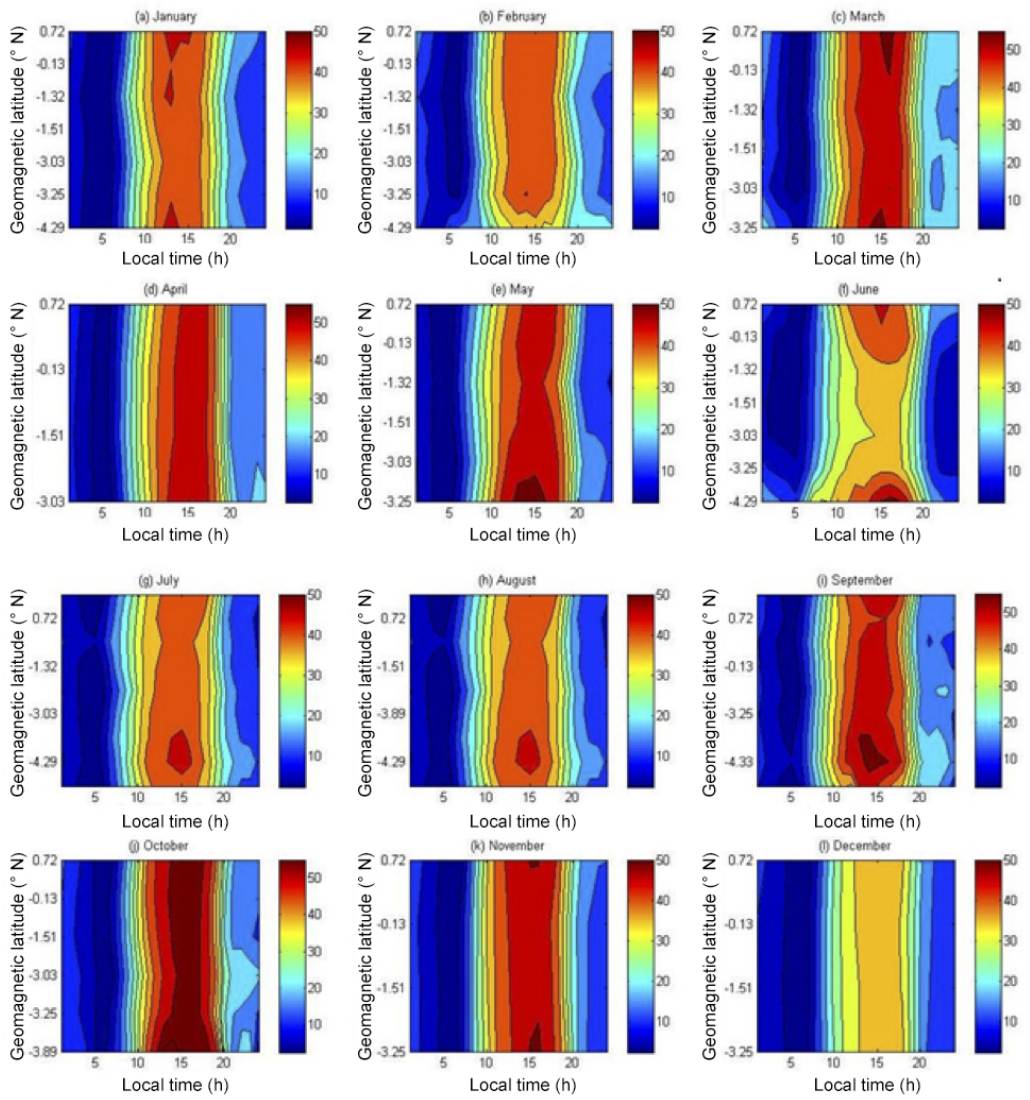
Figure 3. Hourly variation in GPS TEC in all the months along latitude. Data from all stations were used in this figure, except RSUT, CLBR, and FPNO, which were not used to derive maps for the months of March Equinox. Also, RSUT and FPNO were not used to derive maps for the months of December Solstice due to poor data